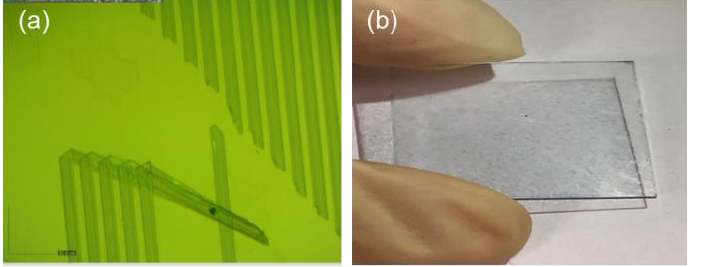
Figure 2. Poly (3,4-ethylenedioxythiophene) polystyrene sulfonate (PEDOT:PSS) film damaged when the substrate was shaken in an acetone bath during the lift-off process. ( a ) Image of the finger-type electrodes observed using an optical microscope. ( b ) Macroscale image of the entire substrate. Specifically, GOPS, a hydrolyzed silane crosslinker, was used to improve the anchor- ing, as its epoxy group can react open under acidic conditions, yielding a hydroxyl group. When GOPS is added to PEDOT:PSS suspensions, the hydroxyl groups strongly interact with the sulfonic acid groups of PEDOT:PSS via hydrogen bonds. The trimethoxysilane groups of GOPS are hydrolyzed in acidic suspensions and become Si–OH groups, which form stable Si–O–Si bonds on the glass surface [32]. To reveal the effects of GOPS in the PEDOT:PSS suspensions, its concentration was varied, and the durability of the resulting PEDOT:PSS patterns was evaluated. As the GOPS concentration increased, fewer defects ended to appear in the PEDOT:PSS patterns. However, 3.0 wt % GOPS caused PEDOT:PSS to agglomerate, which was previously reported to hinder spin-coating [29]. Further, we confirmed that adding GOPS decreased the conductivity of the PEDOT:PSS films, sug- gesting a trade-off relationship between improving the durability and maintaining the conductivity of the PEDOT:PSS films. Figure 3 shows the relationship between the conduc- tivity of PEDOT:PSS films and the GOPS concentration, which shows almost the same trend as that observed in previous work [28], although the initial conductivity without GOPS was slightly lower here. Based on these findings, we used 0.2 wt % GOPS in subsequent experiments because this concentration yielded PEDOT:PSS films that were sufficiently durable during the lift-off